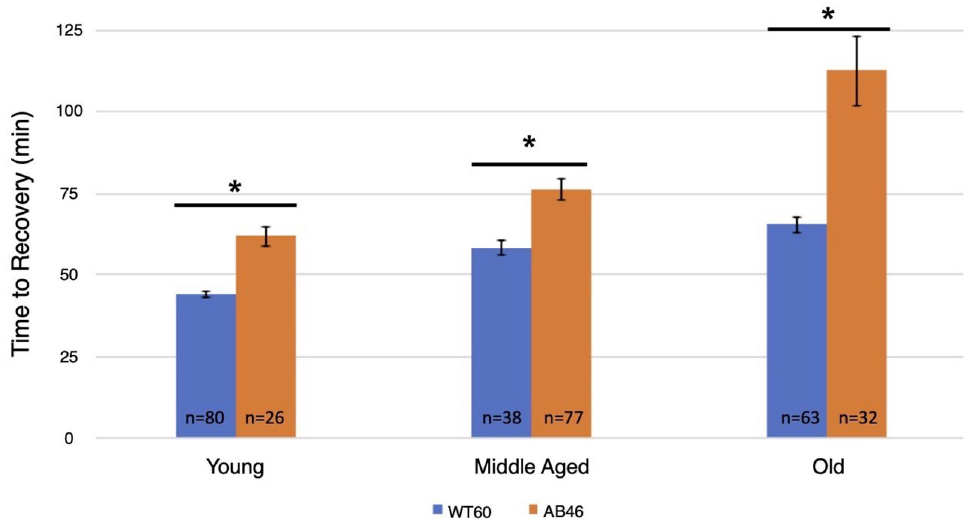
Figure 1. Recovery after one hour hypoxia under rapid induction of spreading depression. Wild-type (WT60) and MSR- deficient (AB46) animals were exposed to one hour of hypoxia using a nitrogen flow rate of 2.0 L/s. After one hour of hypoxia, the animals were returned to normoxic conditions and allowed to recover from the spreading depression coma. Recovery was marked as the time to the first movement detected by the Drosophila Activity Monitor. The number of individual animals ( n ) used for each age-group and genotype is shown on the graph. Error bars are the SEM. Significance is indicated by an asterisk where p < 0.0001 using an unpaired t